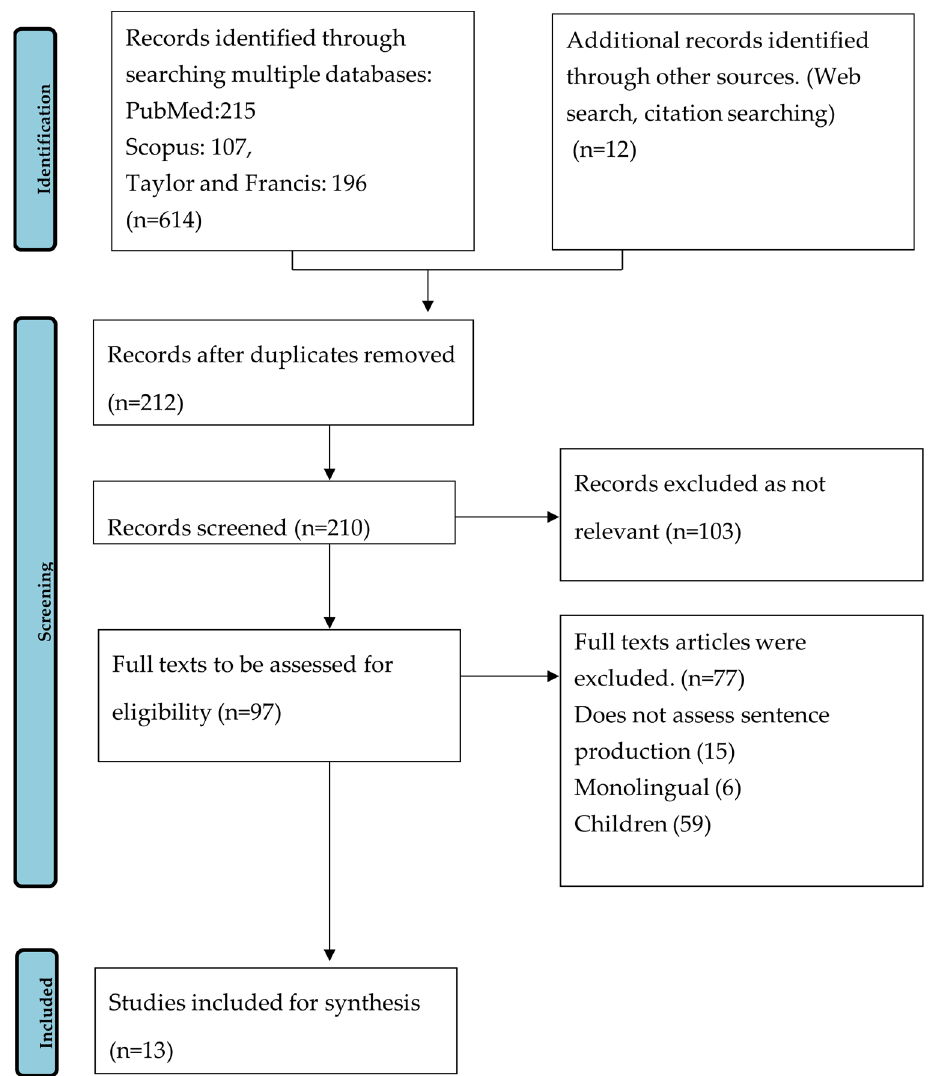
Figure 1. Screening procedure flowchart.